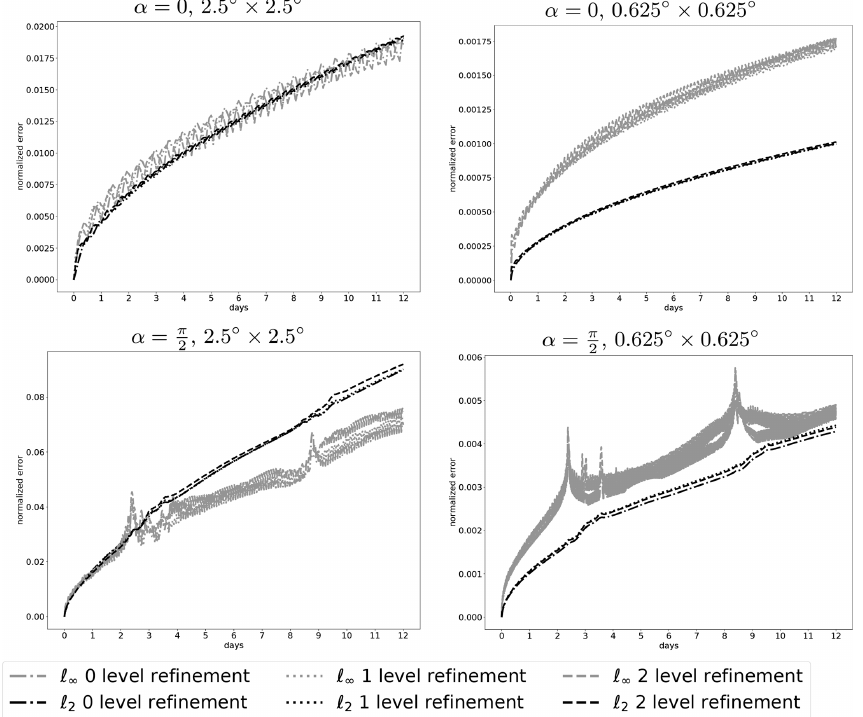
Figure 12. Evolution of the normalized numerical error for α = 0 and α = π The resolution for each figure represents the highest spatial resolution on the